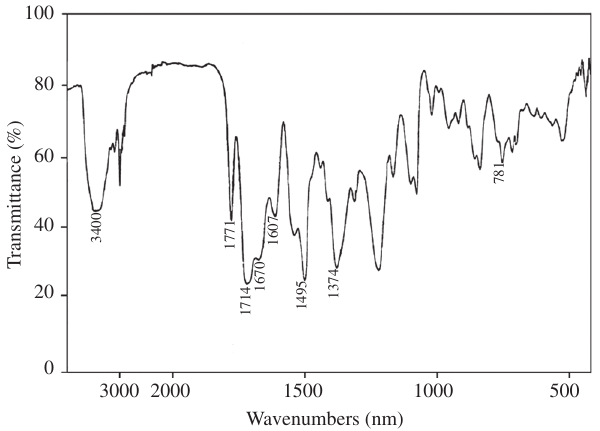
Figure 2 FTIR spectrum of PAI-nanocomposite films